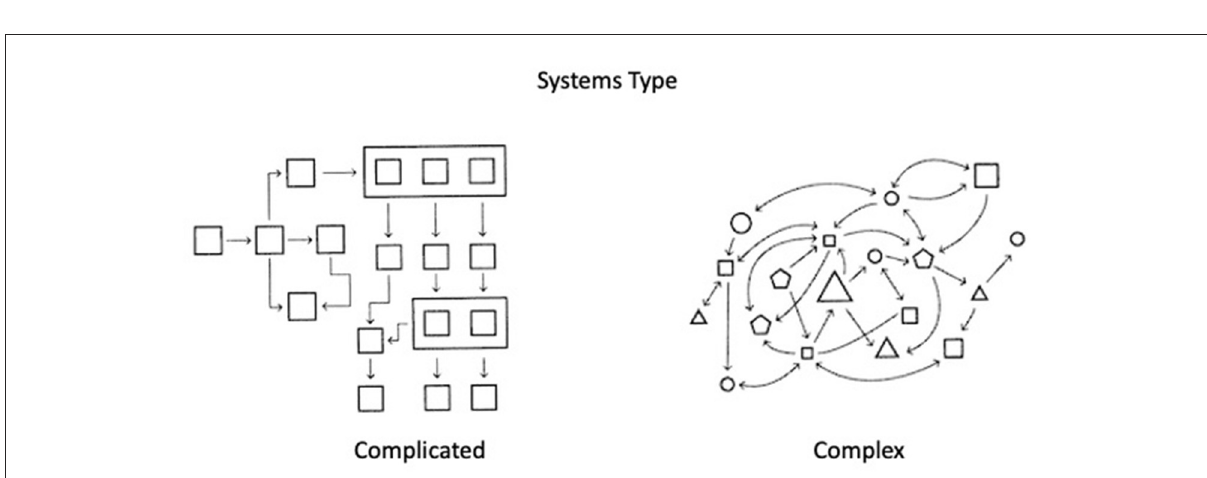
FIGURE2 Systems View: the contrast between complicated and complex systems. Complicated and complex systems can both have many parts but complicated systems have stable structures and the interactions among the parts are deterministic and predictable, while complex systems have many interdependent parts and the interactions can be